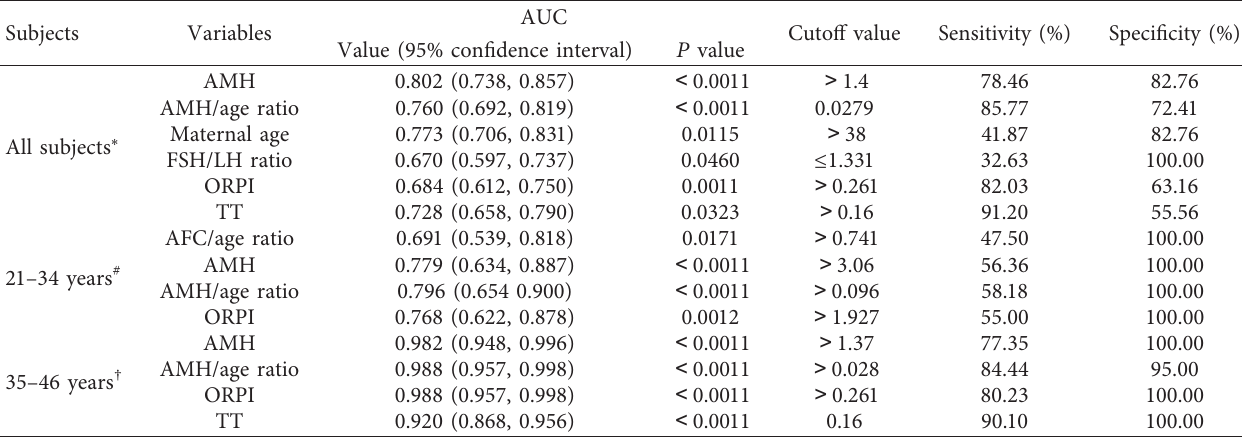
Table 3: The ROC curve, AUC, and cutoff values of variables on predicting oocyte retrieval.